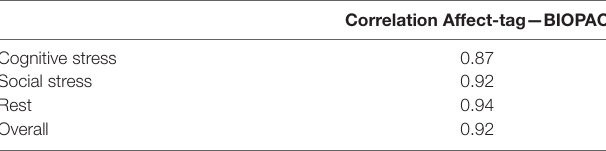
TABLE 1 | Average correlation between Affect-tag and BIOPAC signals during specific tasks.